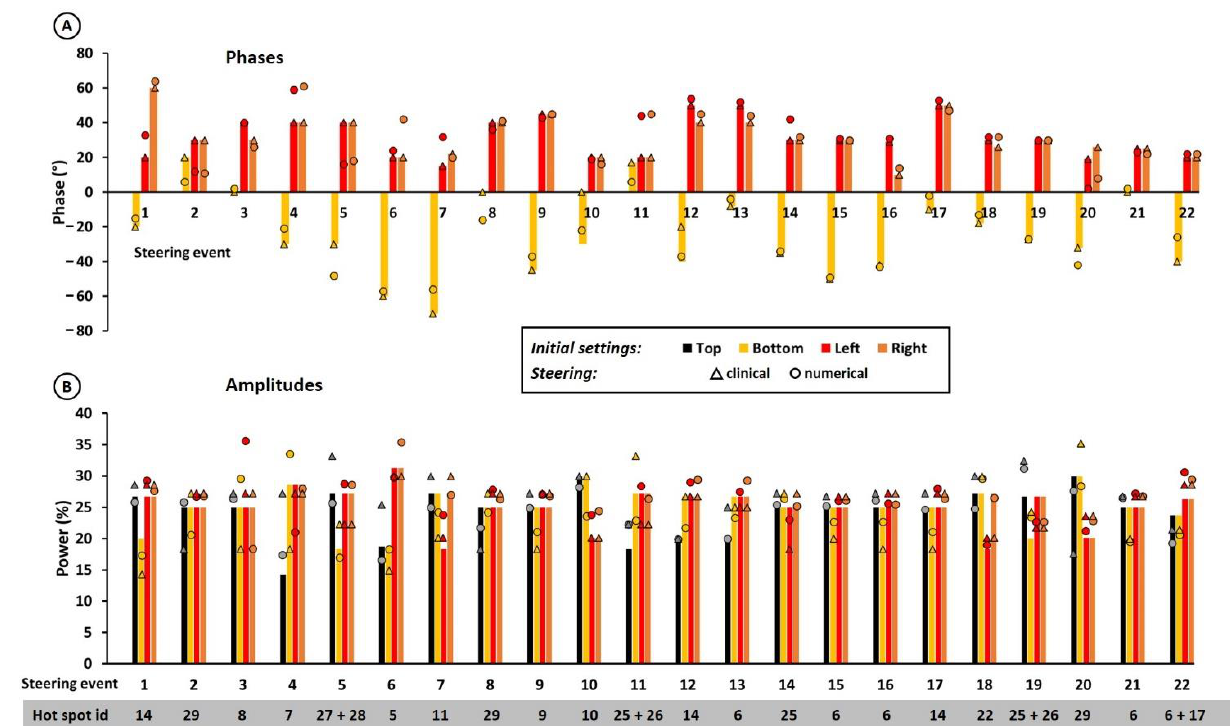
Figure 6. Clinically applied protocol/experience-based phase ( A ) and amplitude ( B ) adjustments and numerically re-optimized settings for a potential hot spot diameter of 5 cm, using a re-optimization goal function with a penalty term for the maximum increase in all potential hot spot temperatures (Equation (3)) and using voxels with the 10% maximum heating potential to calculate the hot spot temperature (10% max EV). The top antenna was always used as a reference, i.e., phase 0°. Hot spot id refers to the anatomical locations in Figure 1A.